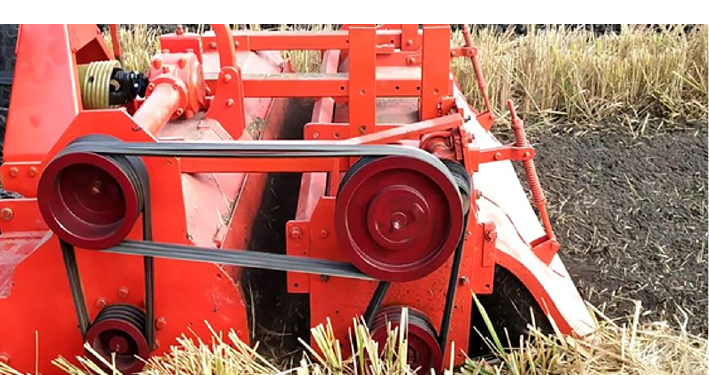
Figure 6. The developed residue management machine during the field test.